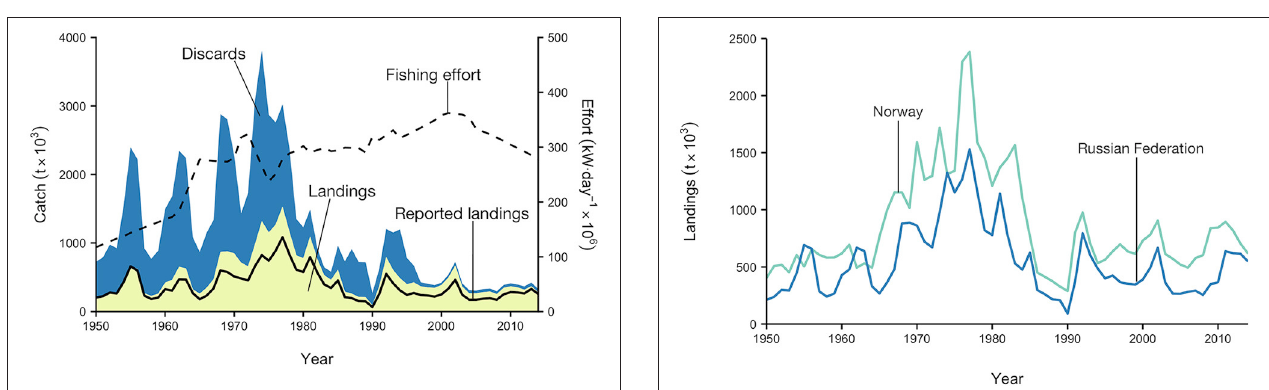
FIGURE 5 | Total reconstructed landings in the Barents Sea (ICES areas Ia and Ib only) by Norwegian (Nedreaas et al., 2015) and Russian